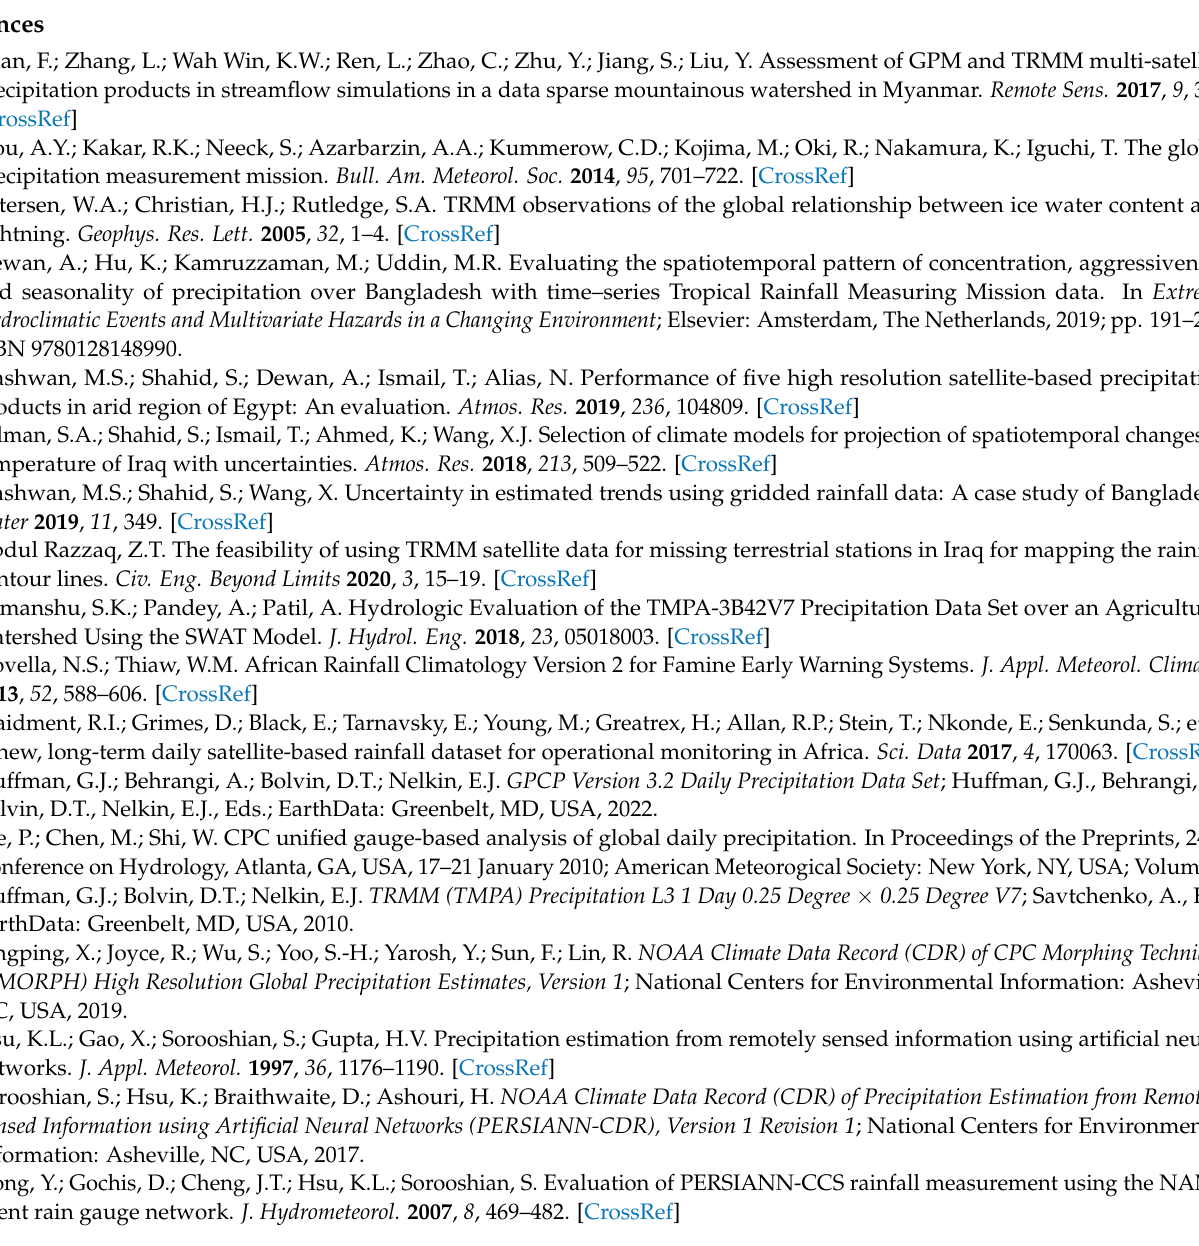
Figure S9. Spatial variation of maximum yearly RB, MAE, and RMSEc over the study area, Figure S10. Variation of RMSEc with gauge altitude for each analysis duration, Figure S11. Variation of MAE with gauge altitude for each analysis duration, Figure S12. Variation of RB with gauge altitude for each analysis